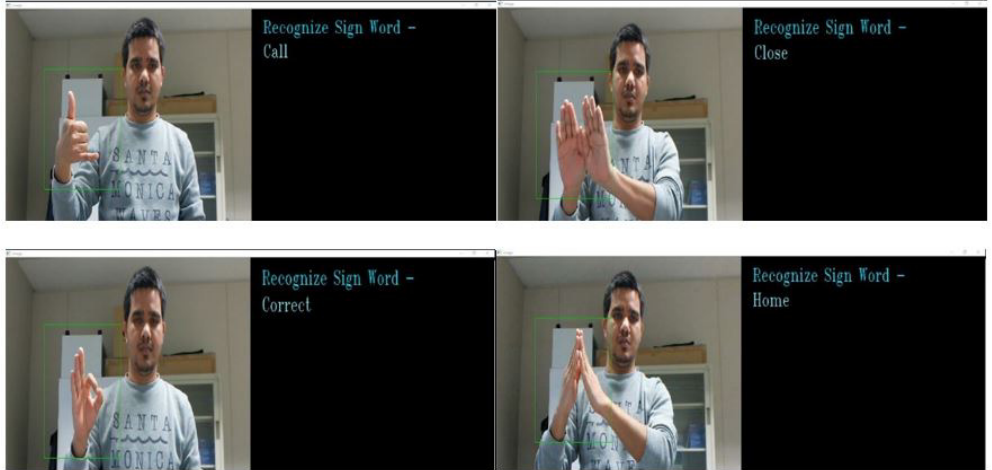
Figure 18. Simulation of the sign word recognition system.